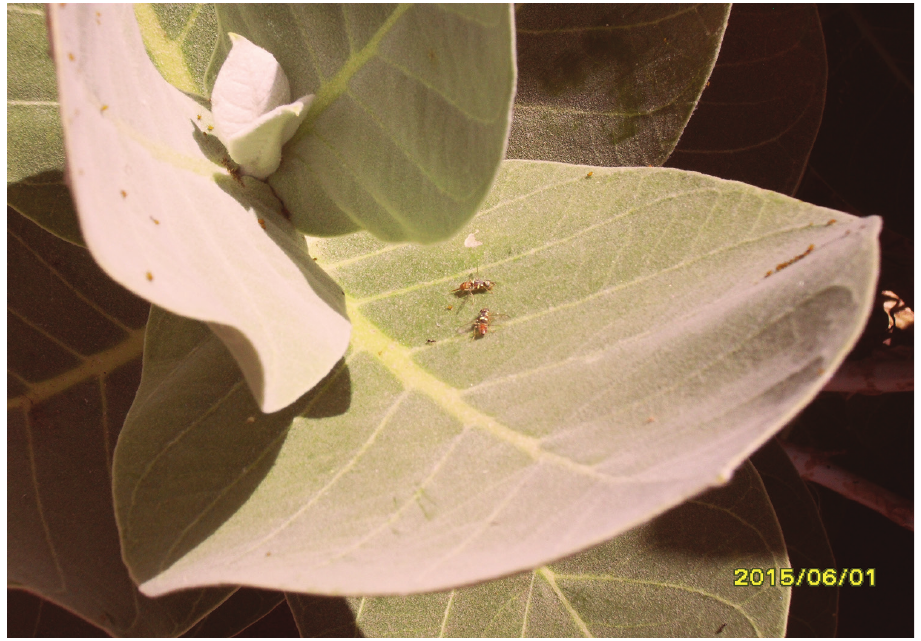
Figure 2. Calotropis procera L., host plant of Dacus longistylus